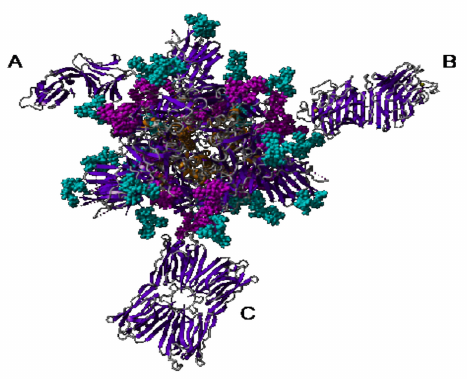
Figure 37. Cartoon showing the relative size of different Man-binding lectins (dimeric GNA-like lectin ( A ), bivalent legume lectin β 2 α 2 ( B ), and Jacalin-related lectin ( C )), complexed to the homotrimeric spike (front face) from